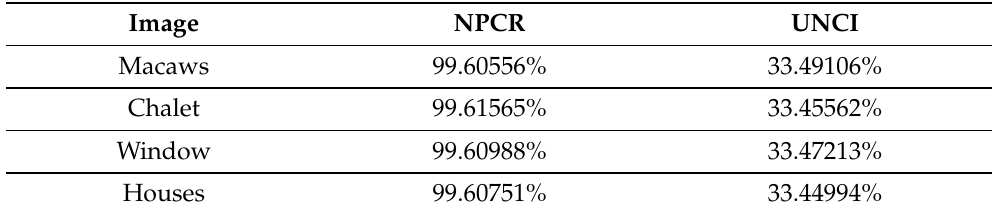
Table 4. Outcomes of NPCR and